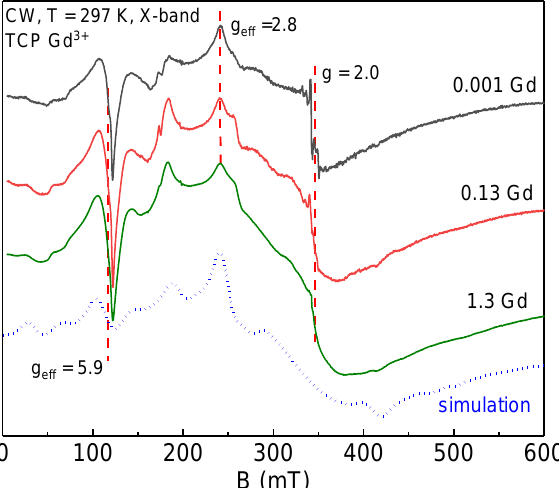
Figure 2. Concentration dependence of the CW EPR spectra in the X-band of TCP-Gd at room temperature supported by corresponding theoretical simulation. The dashed lines point to main spectral features of Gd 3+ ions in crystal lattice.